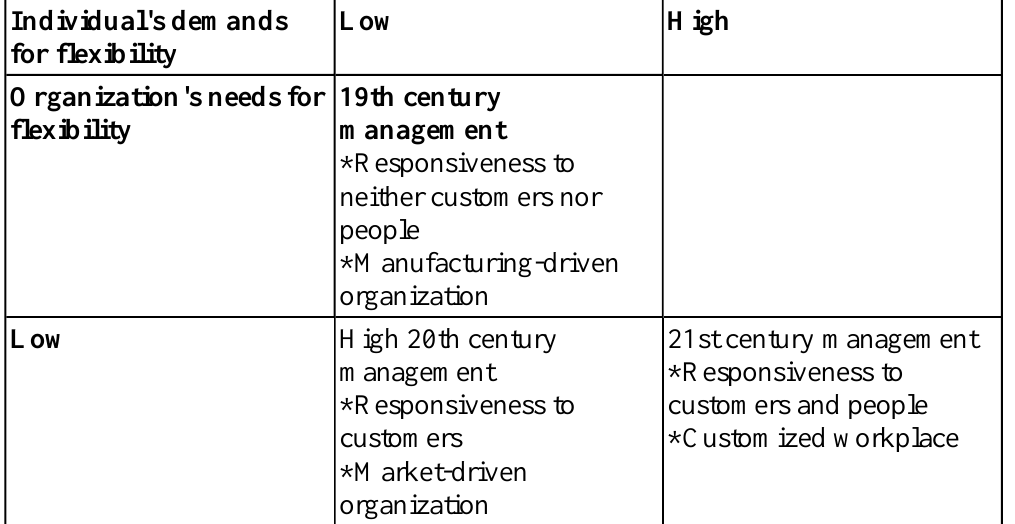
Table 2 Comparing the management framework of three